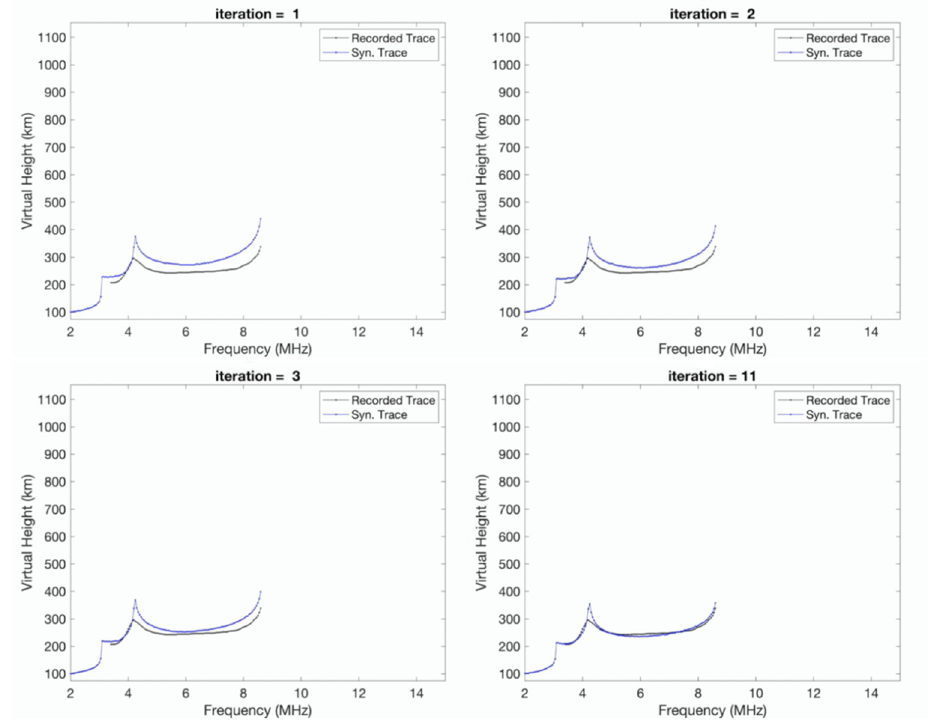
Figure 9. Examples showing the model-simulated ionogram traces that gradually approached the observed traces by adjusting the ionospheric parameters for the MQP-DVW model through stepwise regression analysis.